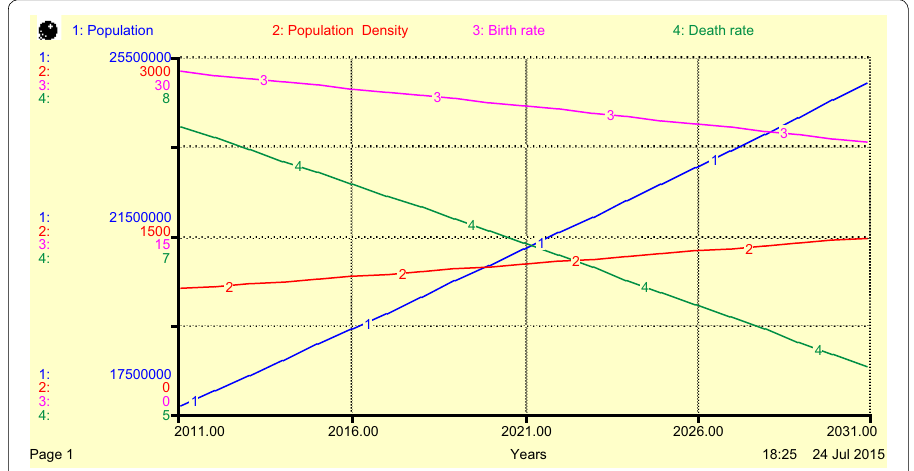
Fig. 17 Perceived projected population, population density, birth rate, and death rate